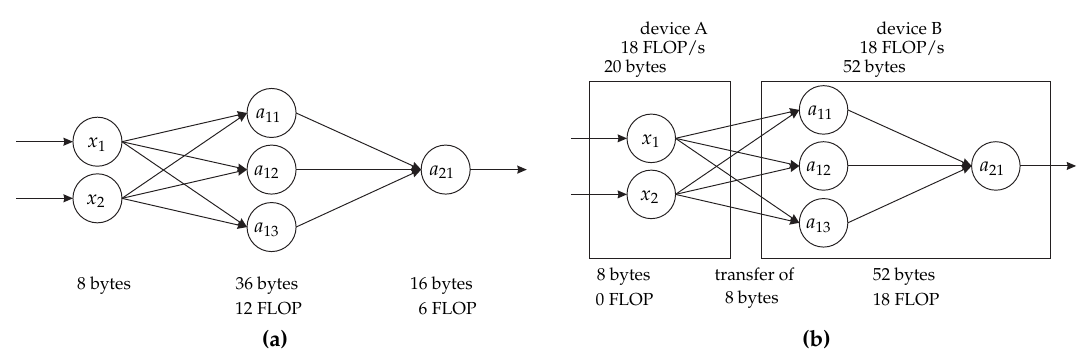
Figure 1. Example of: ( a ) how a fully connected neural network may be represented as a dataflow graph; and ( b ) how it can be partitioned for execution on two